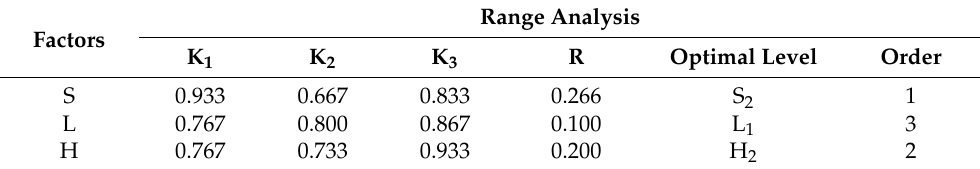
Table 3. Results of range analysis.